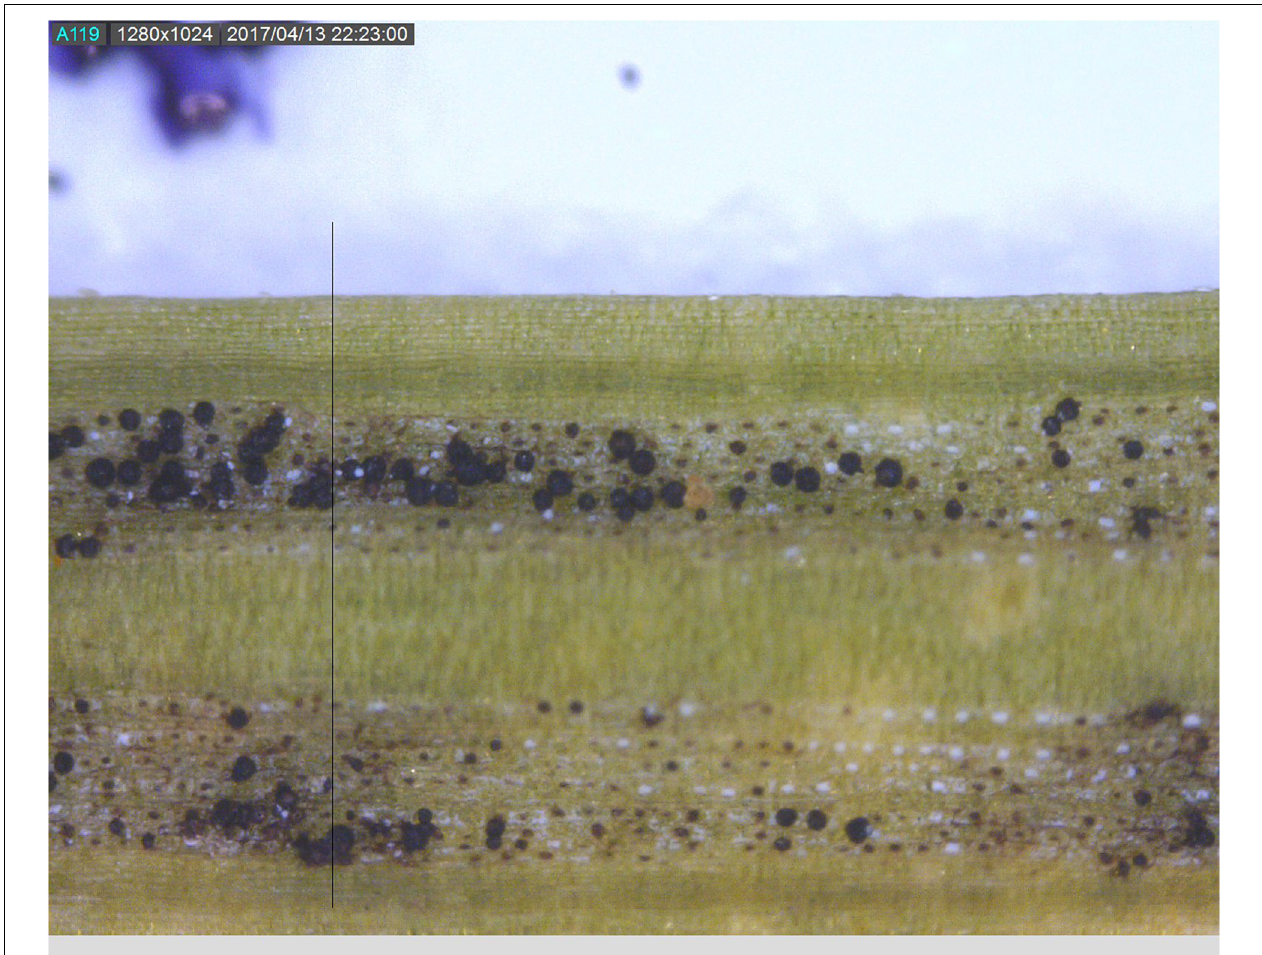
FIGURE 1 | Photo of pseudothecia blocking stomates on the underside of a Douglas-fir